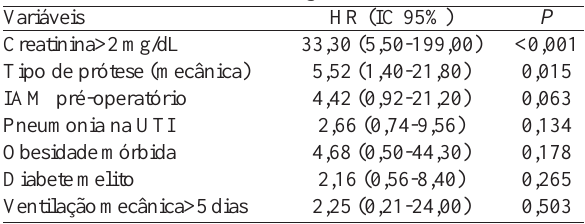
agudo do miocárdio